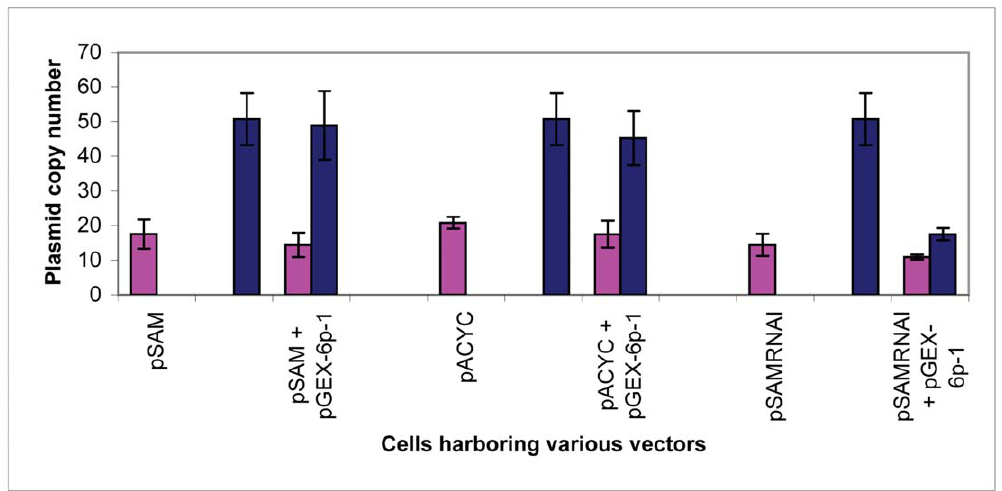
Figure 3. Plasmid copy number per cell as determined by qPCR. Plasmid copy numbers were determined in E. coli DH5 a harboring one or two vectors. In pink is the copy number of all vectors with the p15A ori ; in blue is the copy number of pGEX-6p-1, which is controlled by the pBR322 ori . Plasmids pSAM and pGEX-6p-1 retained their copy numbers both individually and when cells were doubly transformed. This trend for pSAM was similar to that observed with pACYCDuet (a member of the p15A family) both individually and when doubly transformed with pGEX-6p-1. Plasmid pSAMRNAI causes a decrease in the copy number of pGEX-6p-1 when cells were doubly transformed due to the presence of the pET-28a( + )-derived RNAI retained by pSAMRNAI.